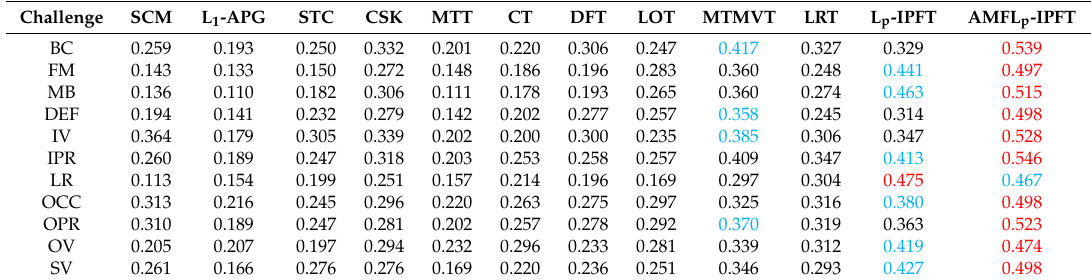
Table 4. ACU results of each tracker on sequences with different challenge for OPE about success.